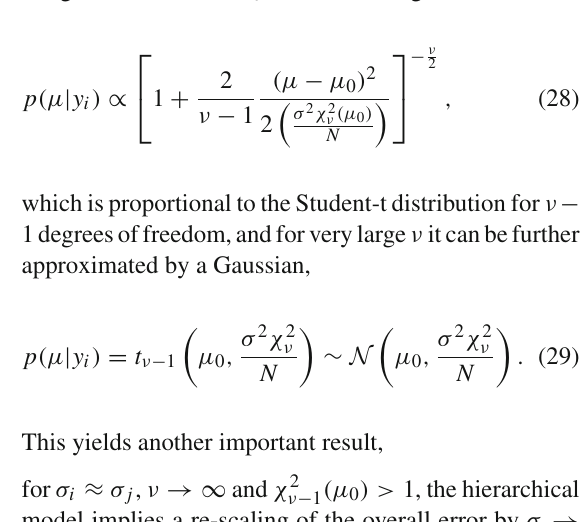
For σ i = σ j the posterior distributions of the hierar- chical and non-hierarchical models peak at the same location.